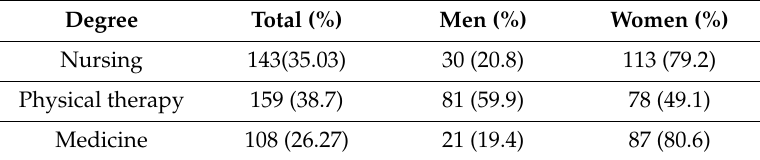
Table 1. Distribution of students according to their degree and